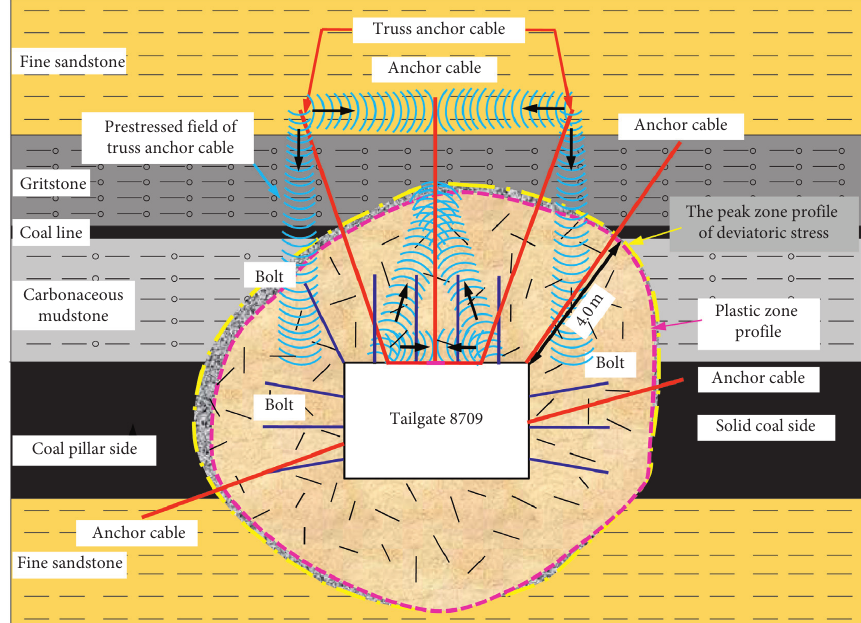
Figure 11: Profiles of peak zone of deviatoric stress and plastic zone of Tailgate